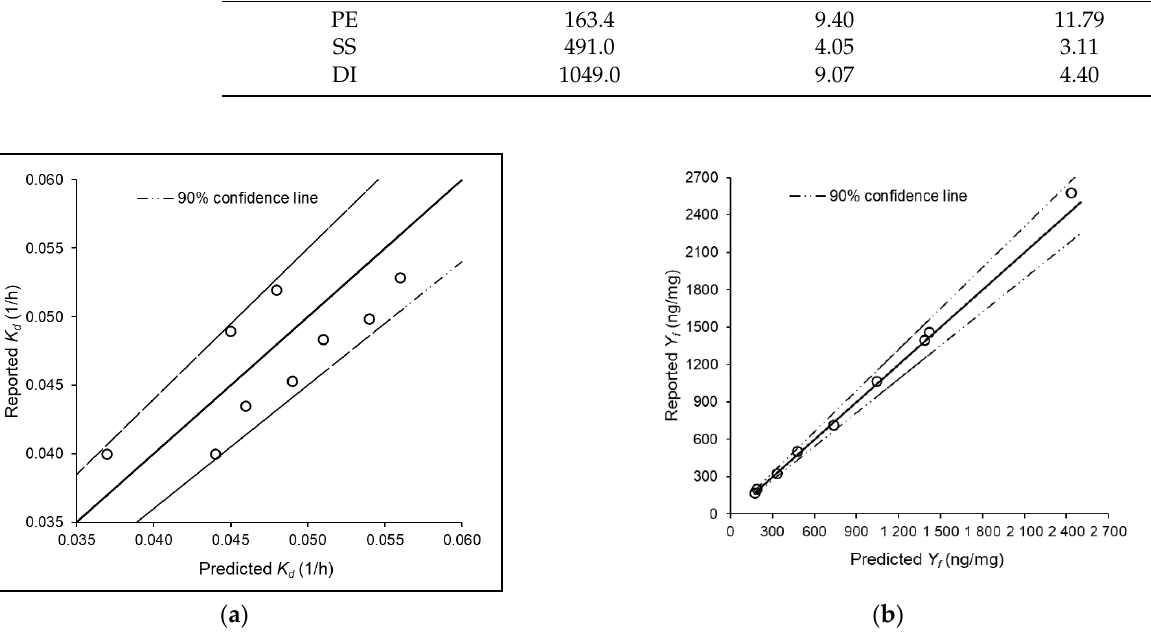
Figure 1. Goodness of fit between predicted and experimentally derived values of ( a ) K d and ( b ) Y f . The open circle symbol represents the experimentally derived value. The continuous solid line symbolizes the perfect fitting and the dashed line represents 90% confidence